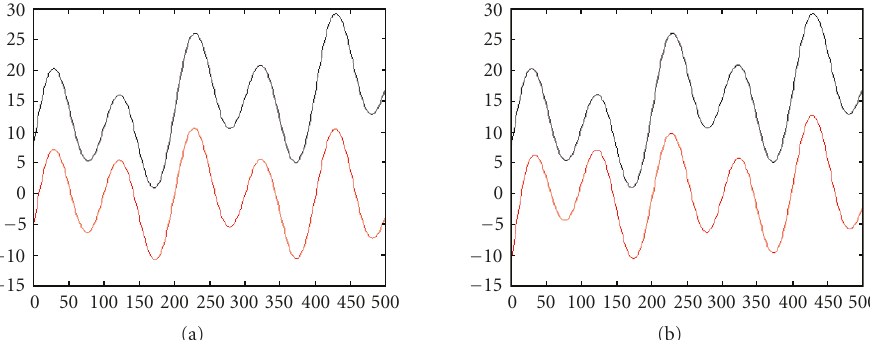
Figure 8: (a) Original signal (top) and mean envelope subtracted signal (bottom) using FABEMD algorithm, (b) original signal (top) and mean envelope subtracted signal (bottom) using BEMD algorithm.